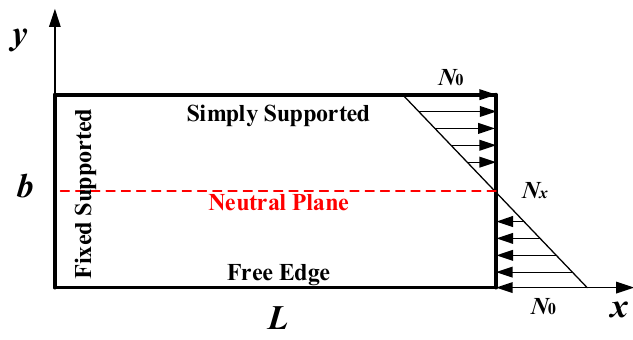
Figure 2. Distribution of applied in-plane stress.